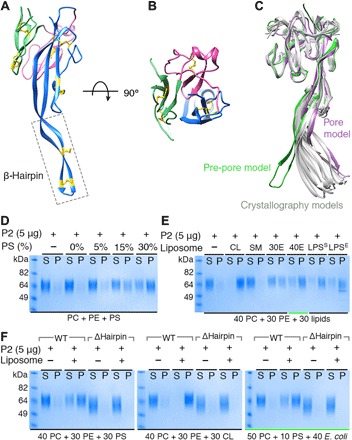
The P2 domain β hairpin is responsible for membrane binding.(A and B) Atomic structure of P2 domain showing pseudo-threefold symmetry repeat colored blue, pink, and green. Disulfide bonds linking the β strands are labeled in yellow; the β-hairpin region is marked with a dashed rectangular box. (C) Superimposition of the P2 cryo-EM structure (pre-pore model in green and pore model in purple) and 10 crystallographically distinct copies of the P2 domain (gray). (D and E) Ultracentrifugation-based liposome-binding assays of mPFN2 P2 domain; the liposomes contained different concentrations of phosphatidylserine (PS) (D) or negatively charged or neutral lipids (E). PC, phosphatidylcholine; PE, phosphatidylethanolamine; CL, cardiolipin; SM, sphingomyelin; 30E, 30% of E. coli total lipid extract; 40E, 40% of E. coli total lipid extract; LPSS, LPS from S. enterica; LPSE, LPS from E. coli. (F) Ultracentrifugation-based liposome-binding assays of mPFN2 P2 domain and P2Δhairpin truncation mutant. Green underlines in (E) and (F) indicate the same liposome composition with 50% PC/10% PS/40% E. coli total lipid extract. WT, wild type.